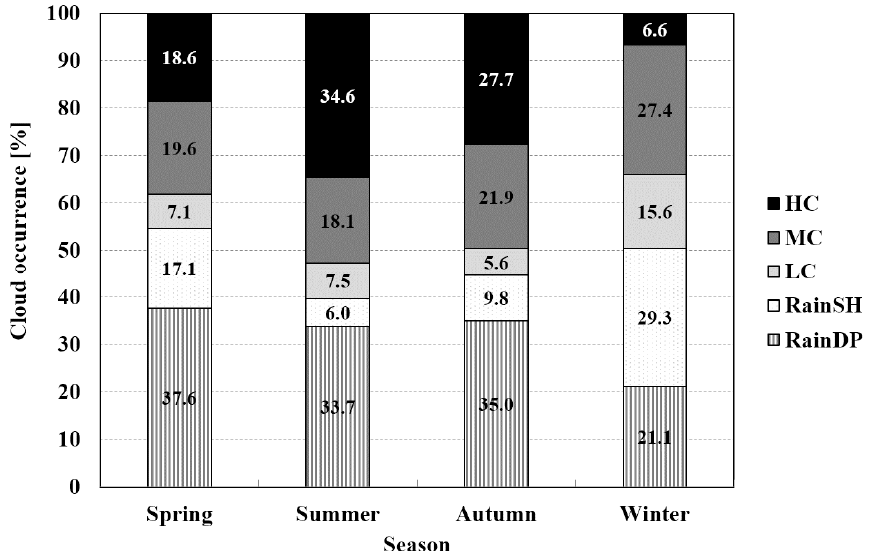
Figure 8. Seasonal frequency of cloud occurrence by cloud types. The frequency is normalized with the